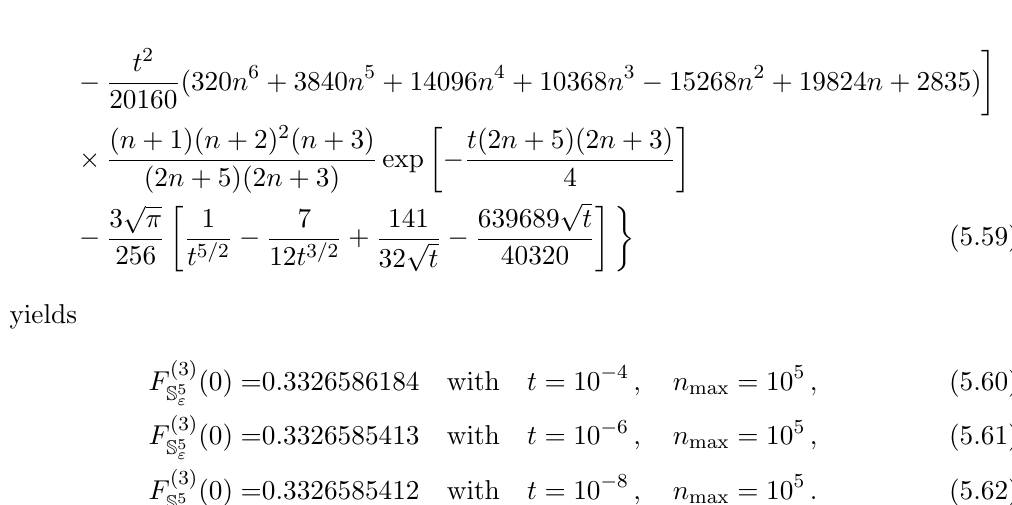
Figure 1 . T ( " ) using numerical data for F S 5 as de(cid:12)ned in eq. (5.63) for values of " near " = 0. The " horizontal gray dashed line corresponds to the predicted value of T (0) assuming the validity of our conjecture eq. (4.13). The numerical data is not well behaved very close to " = 0 due to the 1 =" 3 and 1 =" powers involved in its de(cid:12)nition (see left plot), but the tendency for not so small values of " is very neat, and a proper treatment of the data removing the problematic points shows a perfect agreement with the prediction